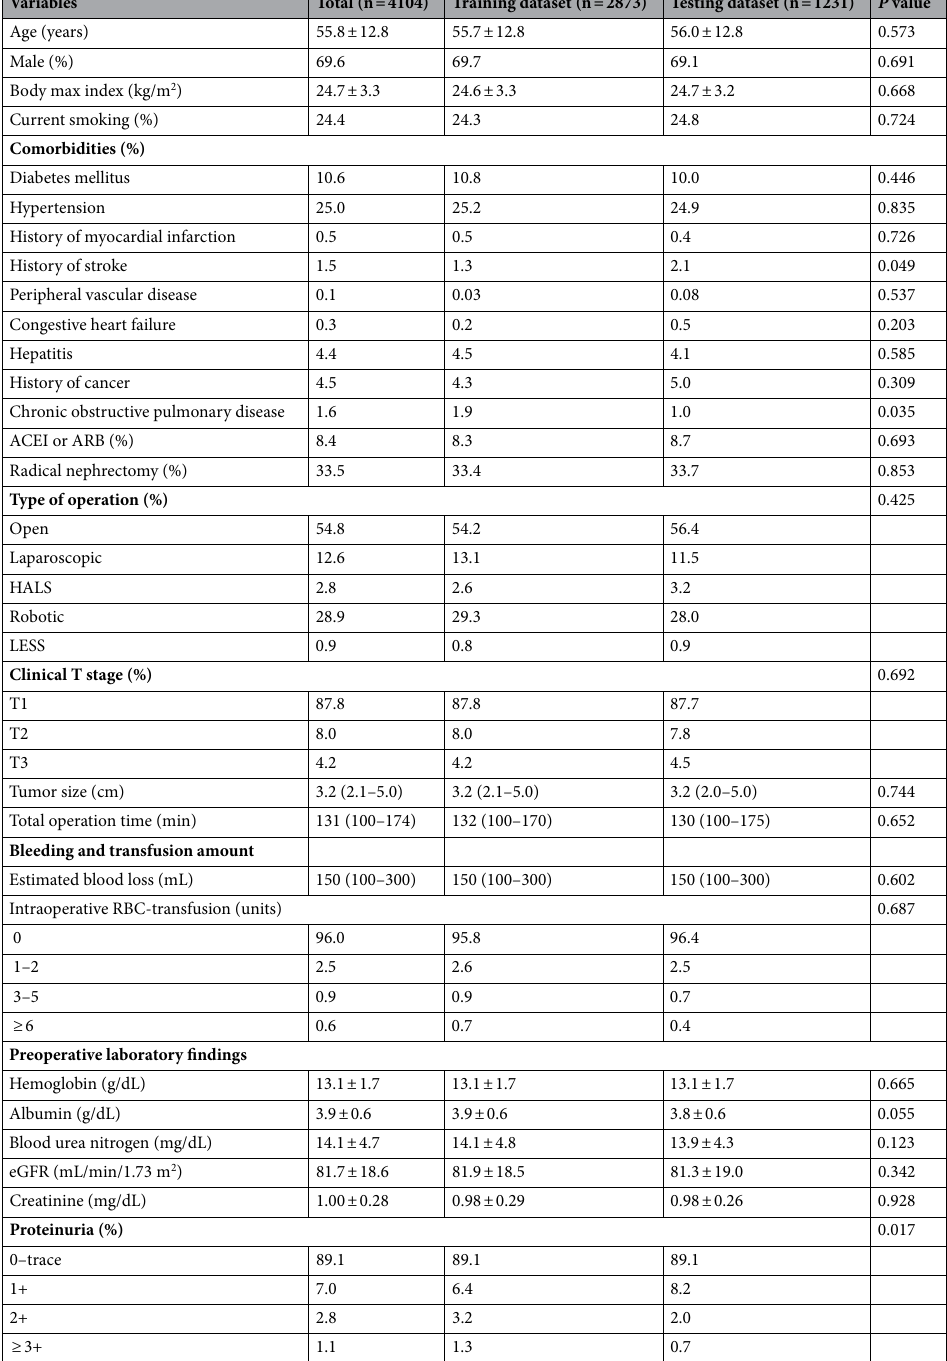
Table 1. Baseline characteristics of the study patients. ACEI angiotensin-converting enzyme inhibitor, ARB angiotensin II receptor blocker, HALS hand-assisted laparoscopic, LESS laparoendoscopic single-site surgery, RBC packed red blood cell, eGFR estimated glomerular filtration